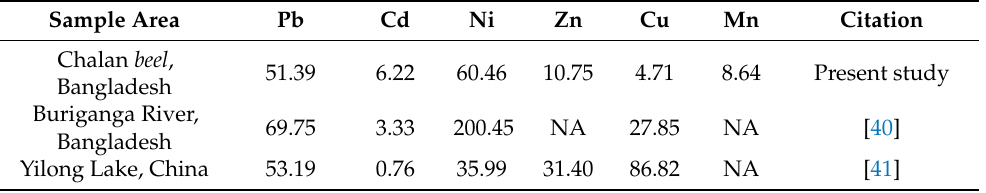
Table 3. Comparisons of heavy metals concentration (mg kg − 1 ) in sediments from Chalan beel with others selected rivers, beels and estuaries around the